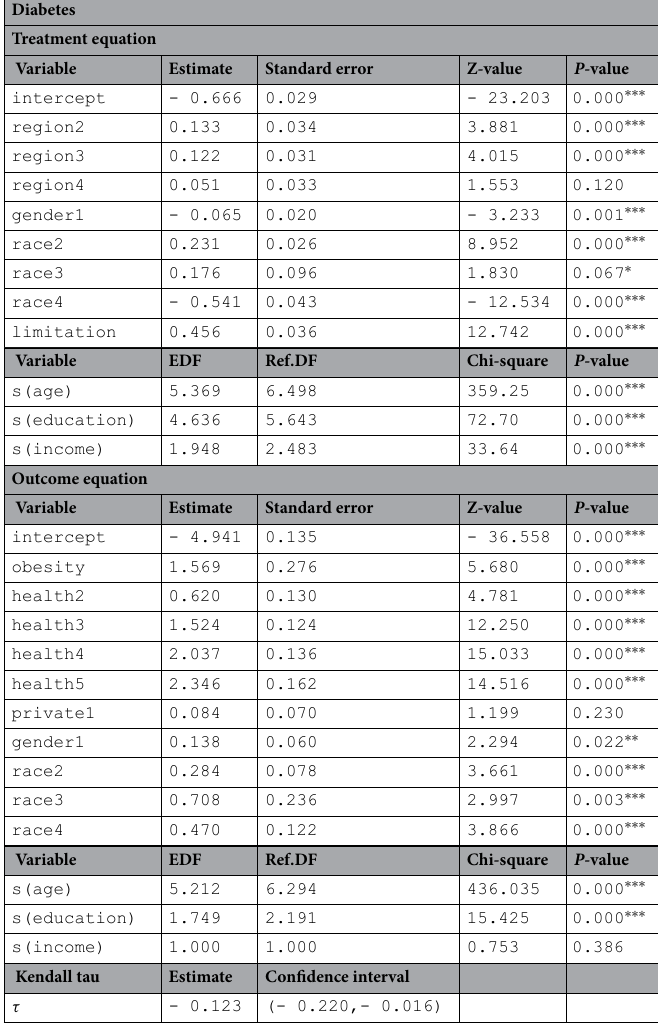
Table 6. Estimated coefficients and standard errors of the parametric and non-parametric components of the Gaussian copula ( N ) for the treatment and outcome equations for diabetes. The models were fitted using the functions gamlss() and gjrm() in GJRM by employing the “ logit - probit ” link functions combination. More details are given in Table